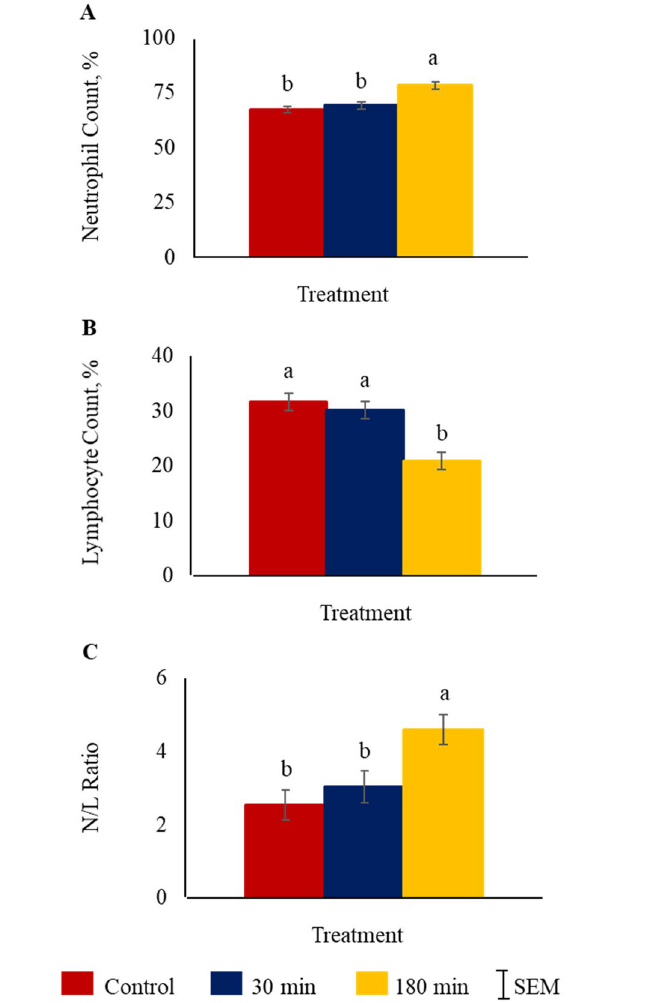
Figure 3. Effects of stress treatment (Control = not transported but held in pens; 30 min = transported for 30 min; 180 min = transported for 180 min) on mean ± SEM ( A ) neutrophil (N) and ( B ) lymphocyte (L) counts, and (C) N/L ratio in goats.